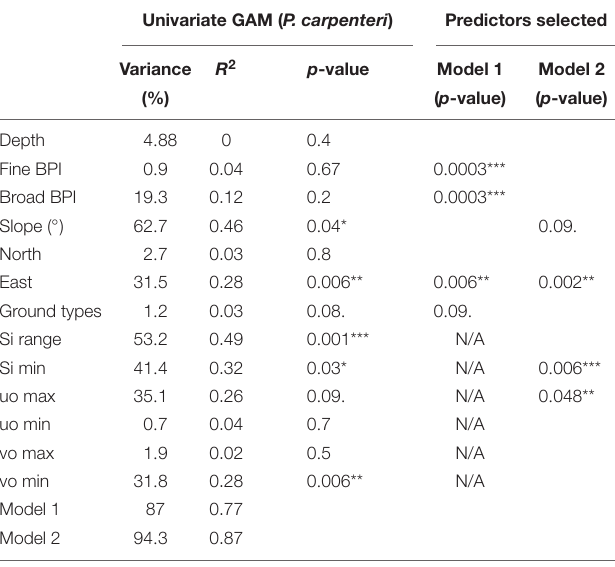
TABLE 3 | Variance, R 2 , and significance for GAM univariate